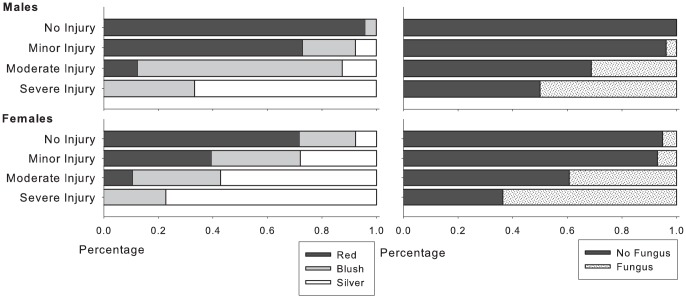
Coloration (left panel) and prevalence of fungal infection (right panel) at spawning streams, as a function of severity of gillnet injury (n = 2365).As color is a qualification of a gradient characteristic, fish were also evaluated as per the extent to which scales were resorbed to further standardize color ranking.